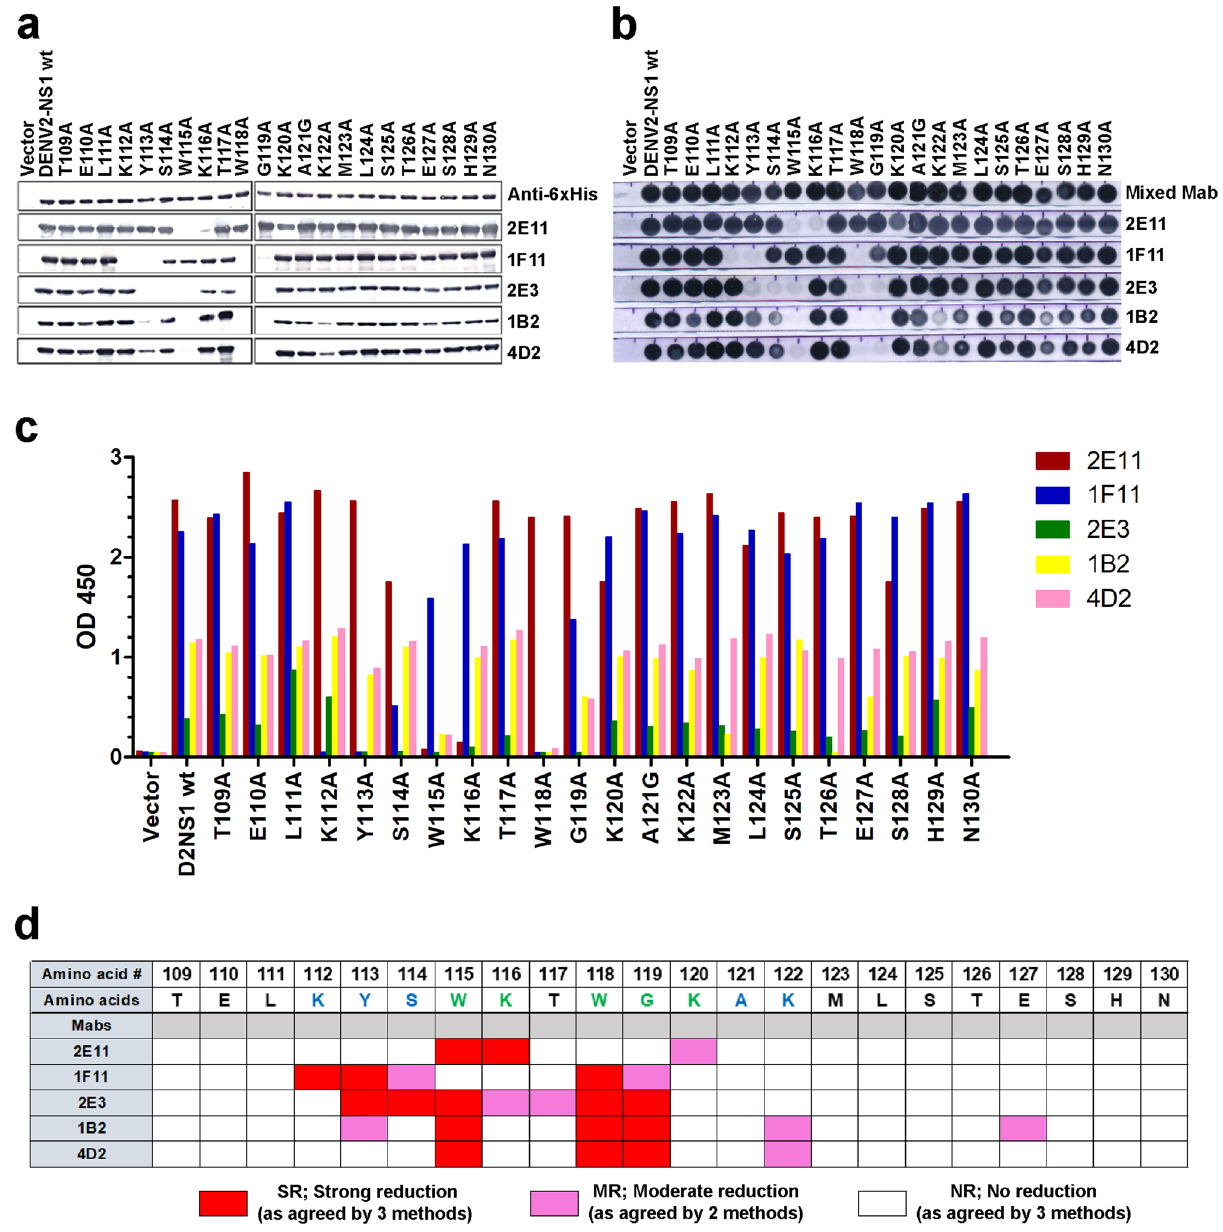
Figure 4. Reactivity of anti-NS1 antibodies to alanine-substituted rDENV2 NS1 mutant proteins. A set of rNS1-6His mutants in which residues 109−130 were substituted by alanine (or glycine for residue 121) were expressed in E. coli . The bacterial lysates of mutants were reacted with anti-NS1 antibodies by ( a ) western blot analysis or ( b ) dot blot assay. Equivalent amounts of rNS1 mutant proteins were applied, as shown by anti-6His antibody (a, upper row) or a mixture of 16 anti-NS1 mAbs that recognized different epitopes on NS1 protein (b, upper row). ( c ) NS1 captured ELISA. Alanine-substituted NS1 mutants (aa 109 − 130) were expressed from transfected imHC cells. Each rNS1 mutant from culture supernatant was captured with anti-6His mAb coated wells and reacted with anti-NS1 mAbs as indicated on the key (2E11, 1F11, 2E3, 1B2 and 4D2) and measured at OD 450 . Cultures from cells transfected with plasmid containing wild-type DENV2 NS1 (NS1-wt) or empty vector were used as a positive or negative control, respectively. ( d ) Assignment of critical binding residues from analysis of mutants. The degree of signal reduction in mutants was determined based on the relative binding index (RI) either by western/dot blot signal intensity or OD reading of NS1 mutant to NS1 wt. i.e. Strong reduction (SR; RI was less than 0.3), moderate reduction (MR; RI was 0.3–0.6) or negligible reduction (NR; RI was greater than 0.6). Substituted residues assigned as SR (Red), MR (Pink), or NR (no color) were congruent by at least 2 assays. NS1 residues conserved among DENV1-4 (blue) or flaviviruses (green) are